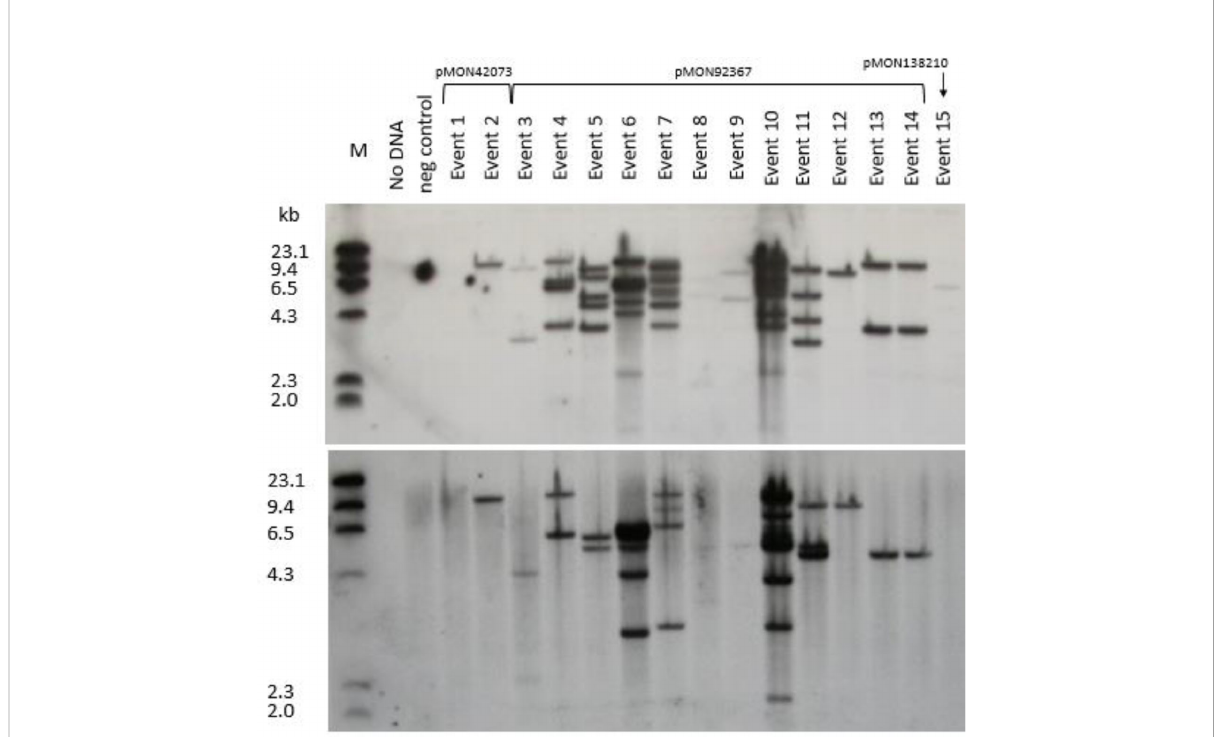
FIGURE 5 Southern blot analysis of 15 primary events from pMON42073, pMON92367, and pMON138210. Information about vector maps, HindIII restriction site location, and probe fragments are described in Supplemental Figure S1. The top panel was hybridized with a gusA probe and the bottom panel was hybridized with a cp4 epsps